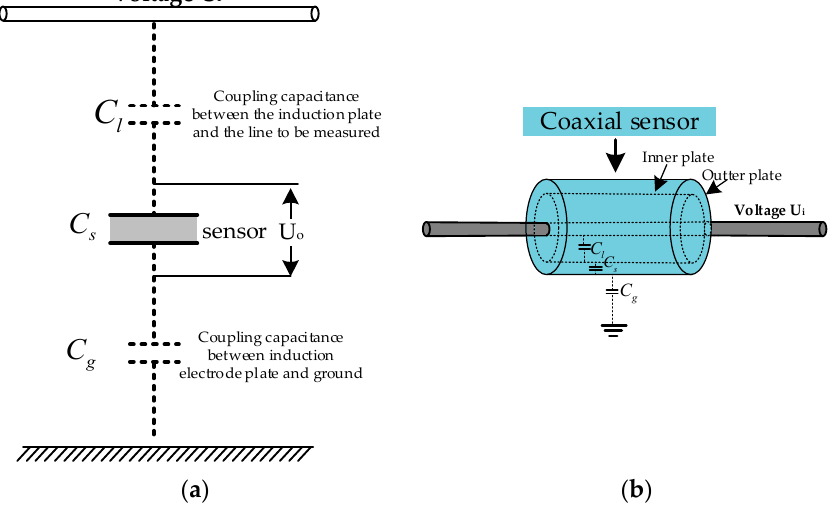
Figure 1. Non-invasive fl oating ground-type three capacitor voltage measurement model: ( a ) Measurement principle diagram; ( b ) Coupling capacitance distribution.